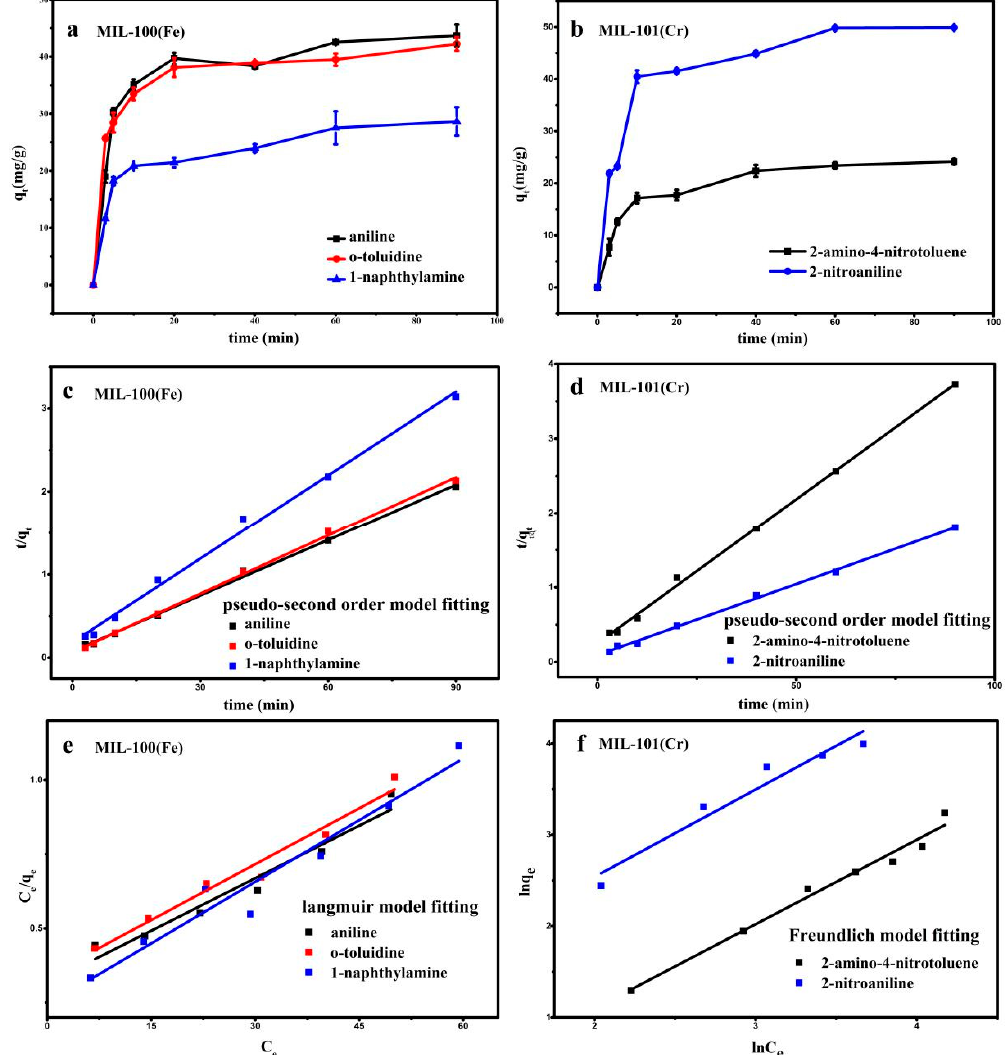
Figure 7. ( a ) The relationship between the amount of adsorption of MIL-100(Fe) and time. ( b ) The relationship between the adsorption amount of MIL-101(Cr) and time. ( c ) The pseudo second-order kinetics of MIL-100(Fe). ( d ) The pseudo second-order kinetics of MIL-101(Cr). ( e ) Isothermal Langmuir model of MIL-100(Fe). ( f ) Isothermal Freundlich model of MIL-101(Cr). Table 1. Kinetic parameters of MIL-100(Fe), MIL-101(Cr) adsorption on aromatic amines.